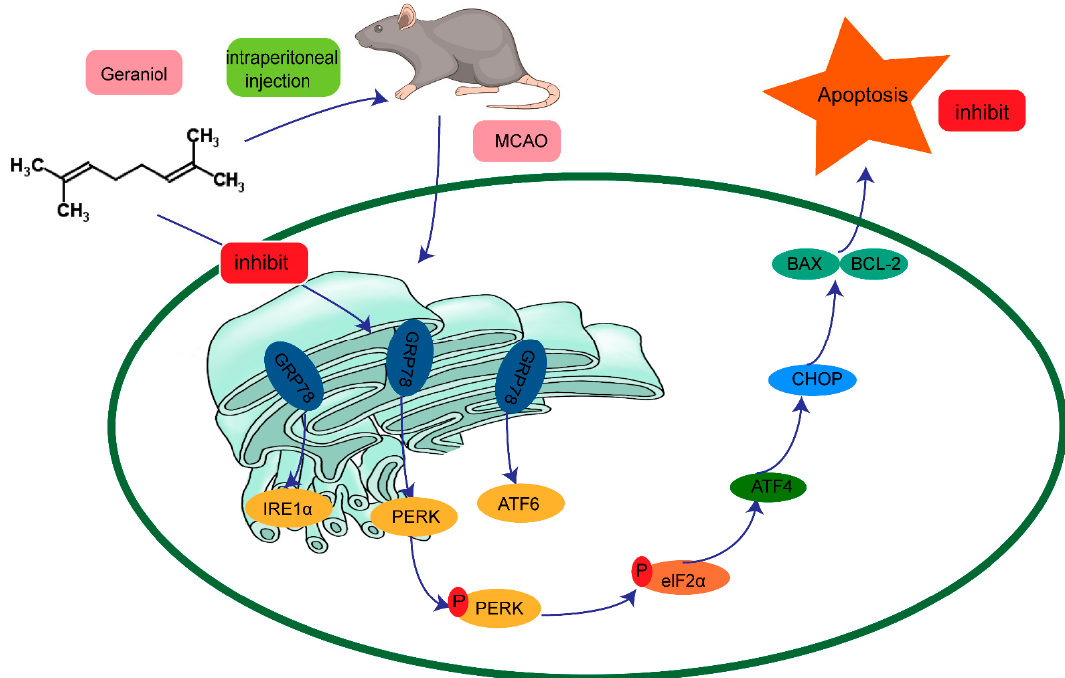
Figure 11. Possible mechanism of the protective effect of geraniol against endoplasmic-reticulum- stress-induced apoptosis after ischemia–reperfusion injury in rat brains.